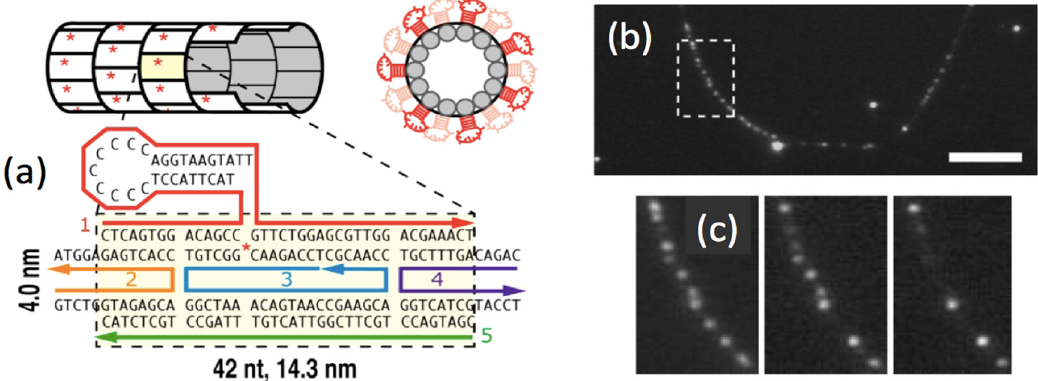
Figure 10. Decoration of a DNA nanotube with fluorescent Ag N -DNA at ~1 µm separations. (Adapted with permission from reference [83]). ( a ) Nanotube design, with a native DNA hairpin extruding from every tile; ( b ) Fluorescence microscopy of nanotubes assembled with hairpins on 0.5% of tiles. Direct synthesis onto the assembled tubes produces bright emission spots from fluorescent red silver clusters; ( c ) Photobleaching of emission spots along the linear nanotube contour enables estimation of ~45% initial occupation of hairpin protrusions by the unstable red